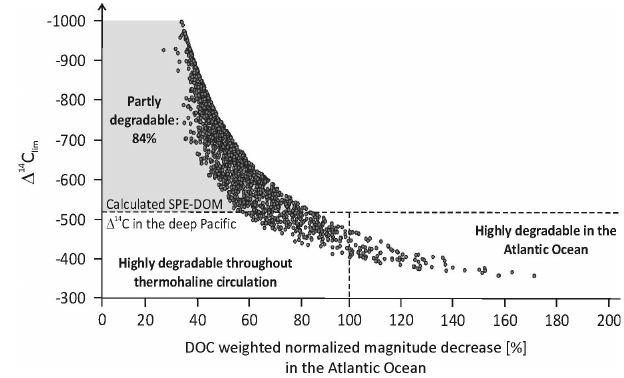
Fig. 10. Calculated limit of 1 14 C ( 1 14 C Lim ) for Atlantic Ocean SPE-DOM compounds, represented by FT-ICR mass peaks versus the calculated, DOC weighted normalized magnitude decrease of SPE-DOM in the Atlantic Ocean (x-axis, [%]). All compounds are expected to decrease with increasing SPE-DOM age, but with different rates (between 22–167%). The relative decreases were calculated using a linear regression model (ordinary least squares, all 137 samples), resulting in predicted decreases > 100% for some compounds. These compounds are yet observed to be highly degraded in the oldest SPE-DOM in the Atlantic